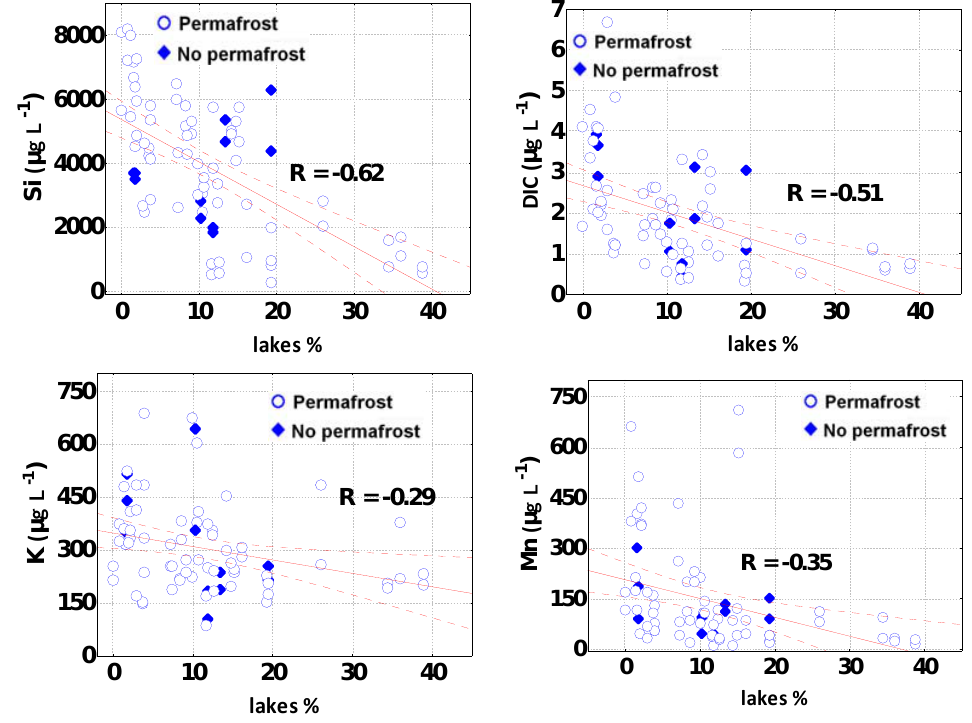
Figure 4. Si, DIC, K, and Mn relationships (R is the Pearson coefficient) with lake proportion on the watershed in permafrost ‐ free (open circles) and permafrost ‐ bearing (closed diamonds) rivers sampled in June and August. The two sampling periods, June and August, are combined together. The solid line is for the main trend and the dashed lines are significant at p < 0.05.